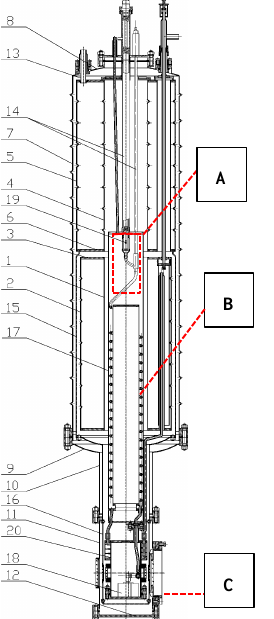
Figure 6. The FST-LM construction: ( A ) Protection-sluice module, which serves to accommodate the shell container (SC); ( B ) Layering channel (LC); ( C ) Test chamber (TC). 1—cryostat